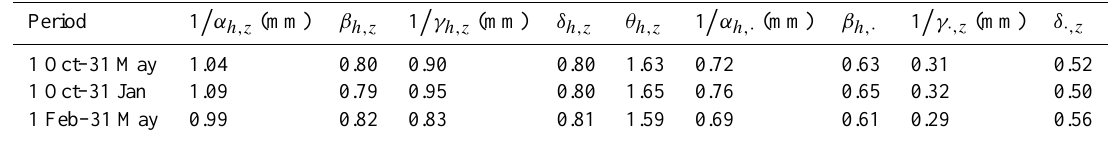
(cid:16) (cid:17) (cid:16) (cid:17) + , · ) + , + ) (cid:0) h (cid:1) and f ( · , + ) z (ν) h i + 1 ,z (ν) . , f ( i + 1 i i H i + 1 , 0 H i + 1 ,Z (ν) i 0 ,Z (ν) i